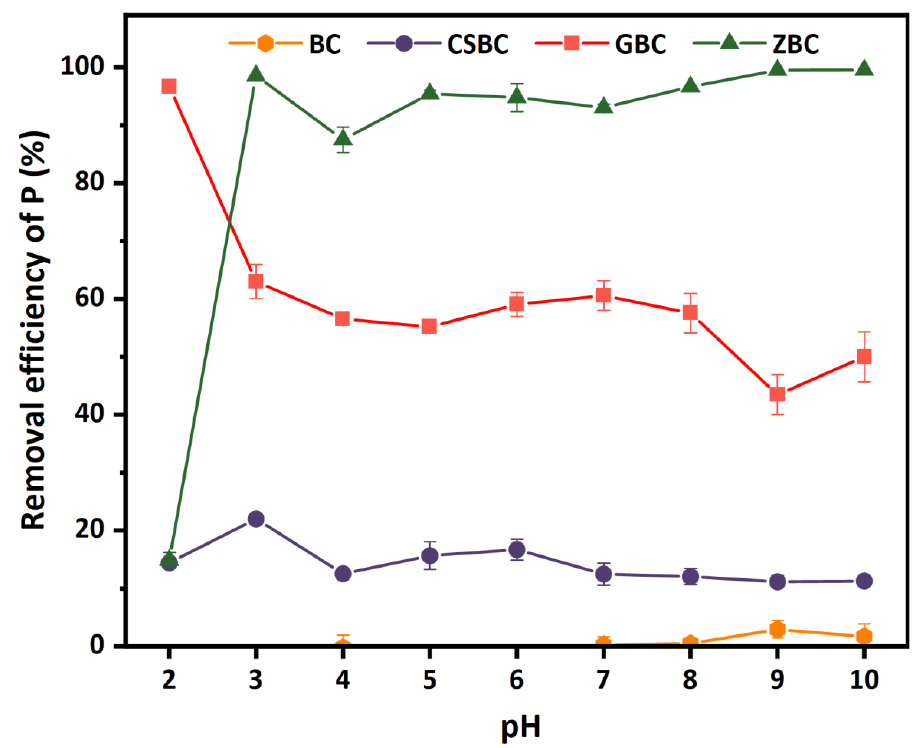
Figure 2. Effects of different pH levels on the P adsorption in BC, CSBC, GBC, and ZBC. (Adsorbent dose: 5 g L − 1 ; P initial concentration: 15 mg L − 1 ; adsorption time: 4 h; temperature: 25 °C; ionic strength: 0.01 M.)